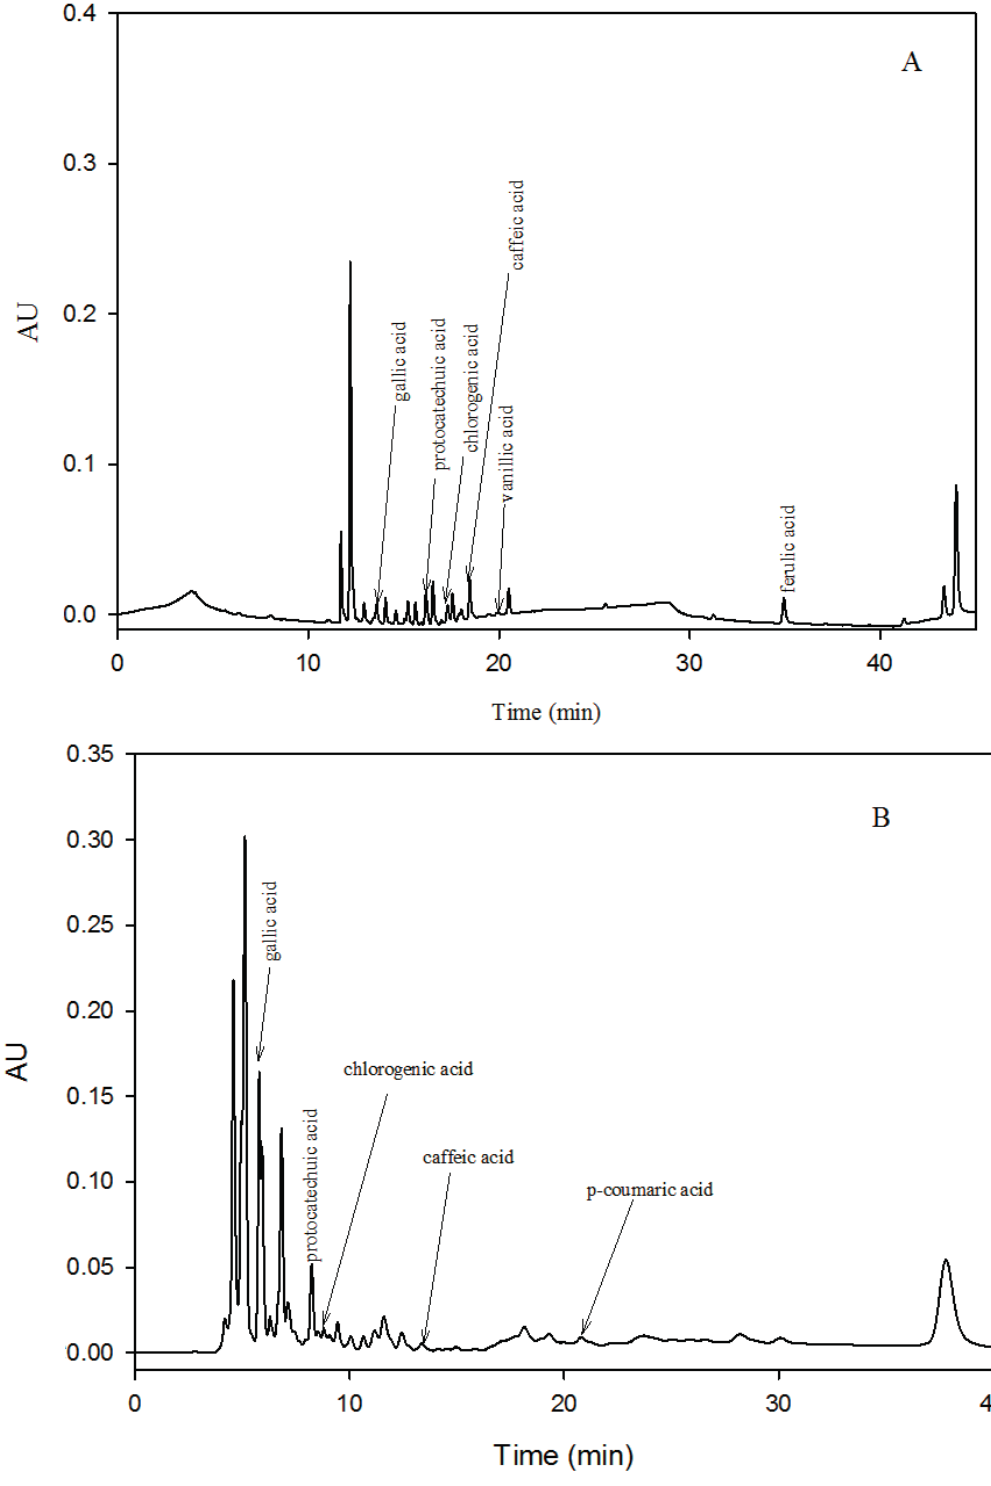
Figure 1. ( A ) HPLC-chromatogram showing the phenolic acid composition in the pulp samples of mango recorded at 280 and 320 nm; and ( B ) HPLC-chromatogram showing the phenolic acid composition in the peel samples of mango recorded at 280 and 320